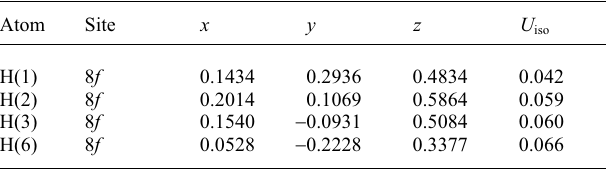
Table 2. Atomic coordinates and displacement parameters (in Å 2 ) .